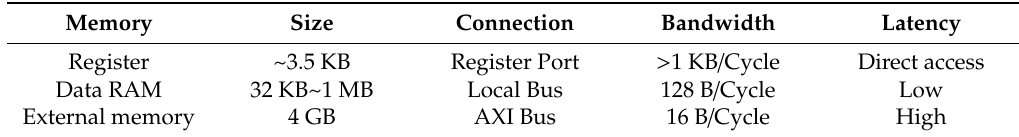
Table 1. Vision DSP memory